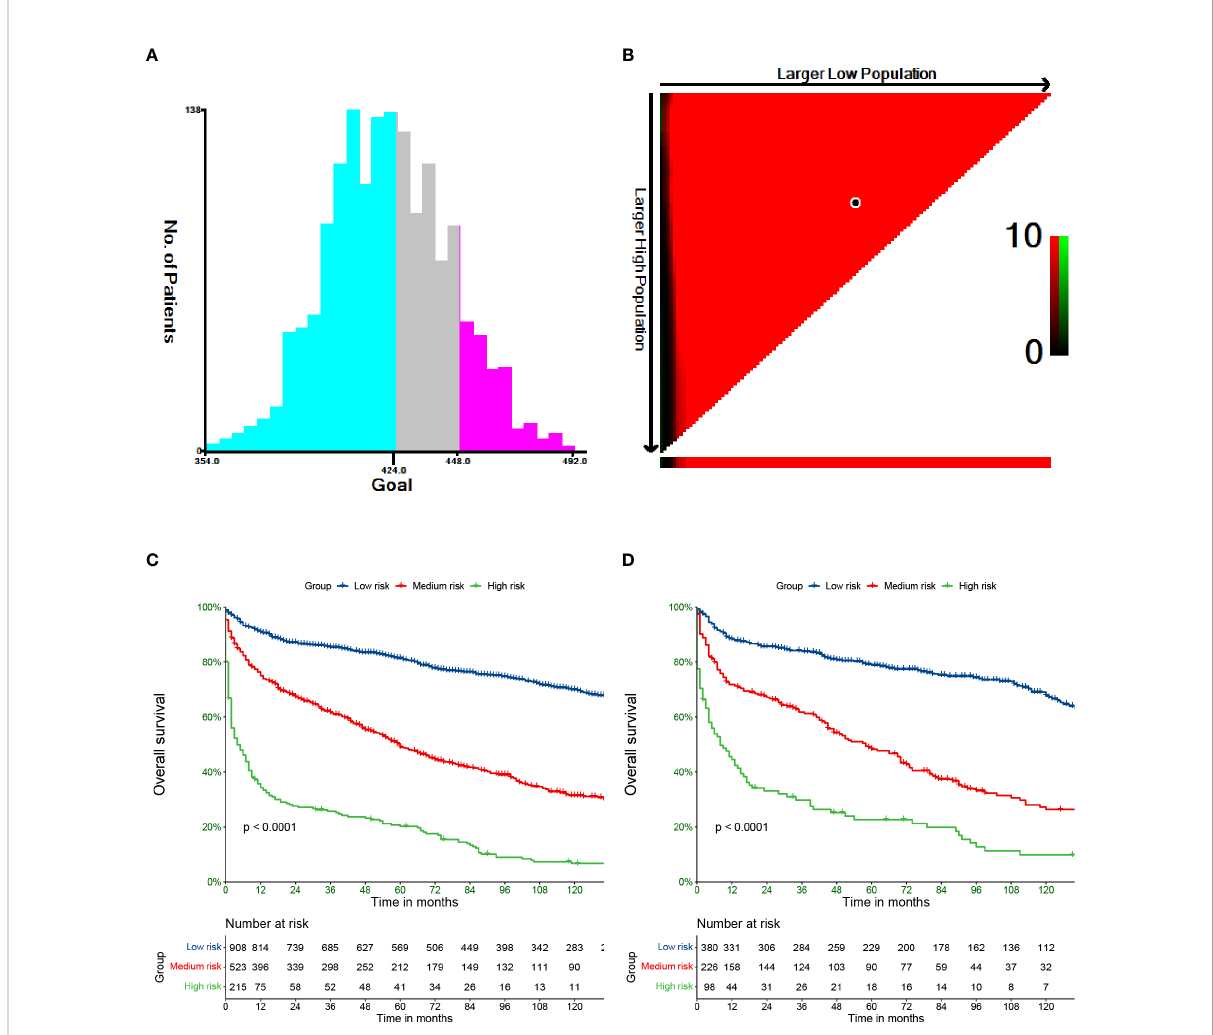
FIGURE 5 Cut-off values calculated by X-tile (A, B) . Overall survival of PCL strati fi ed by risk in training (C) and validation (D)